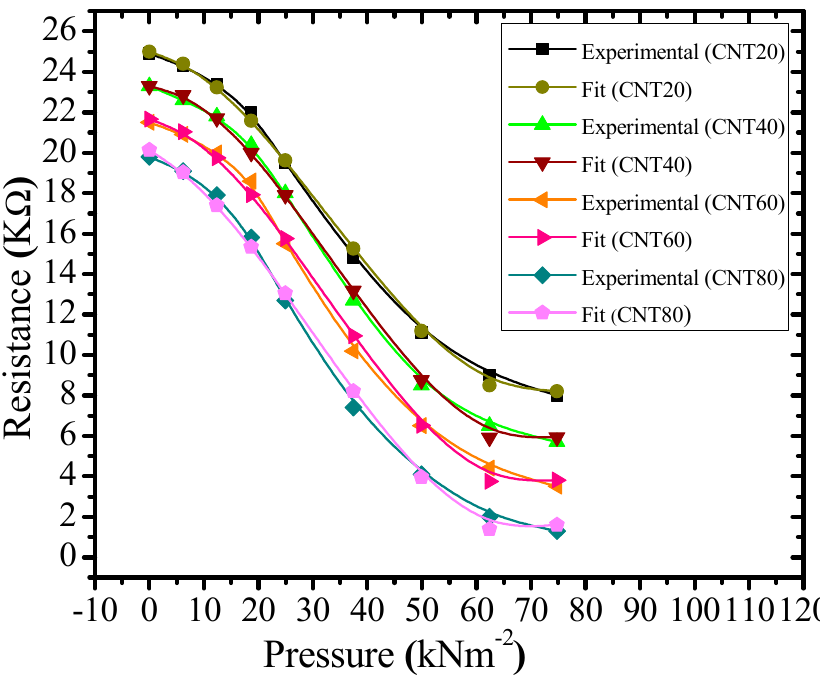
Figure 9. Resistance-pressure characteristics of experimental data (Figure 8) and fitted curves (Equation (4)) for CNT-graphene composite-based piezoresistive pressure samples with weight percentages of 20%, 40%, 60%, and 80% of CNTs.